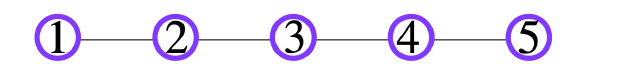
Figure 1: System with Open Boundary Conditions. If the state is translational invari- ant, then the reduced density matrix on sites 1 and 2 is the same as the one on sites 3 and 4, but is different from the one on sites 5 and 1